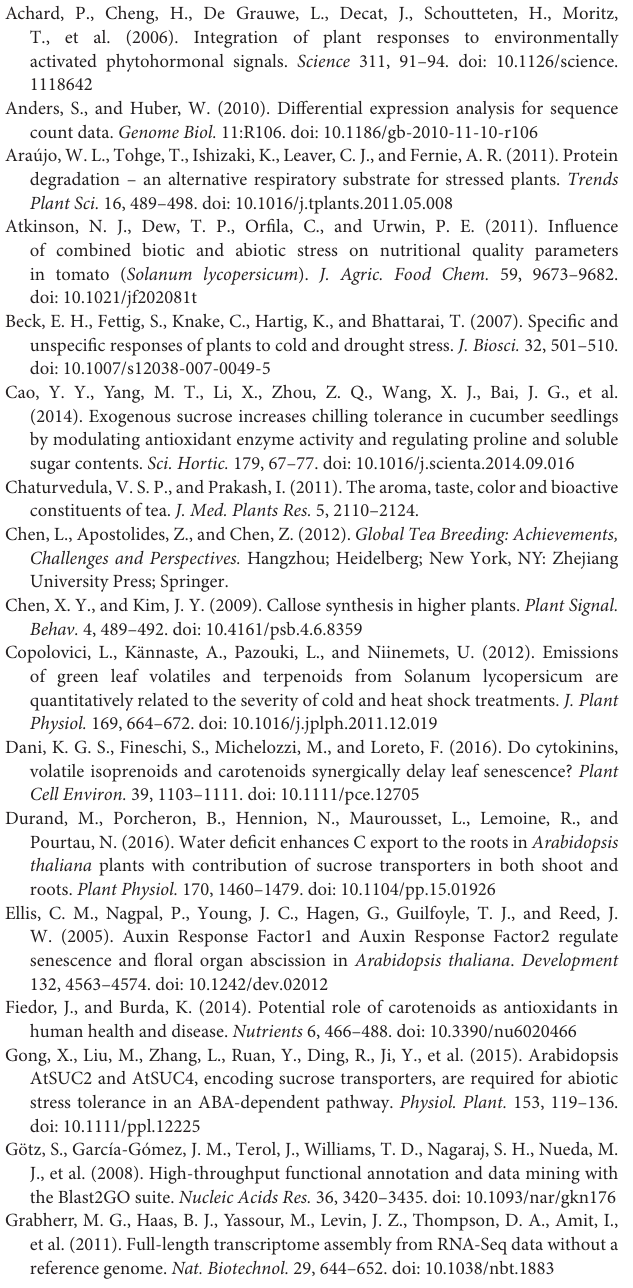
Supplementary Table 9 | List of candidate genes for enhancing plant resistance to combined CD stress. Supplementary Table 11 | List of DEGs in the regulatory model. Supplementary Table 12 | Sequences of primers used for the qRT-PCR assay. Supplementary Table 13 | Abbreviations